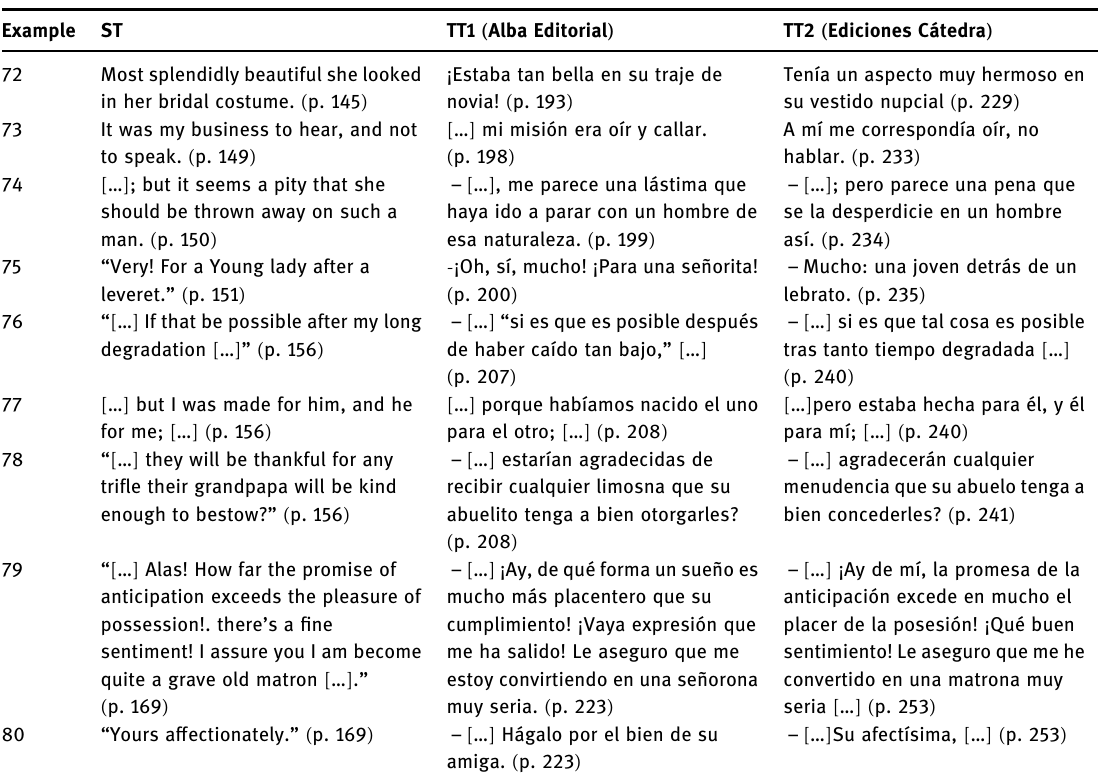
Table 15: Examples taken from Chapters 18, 19 and 21 Example